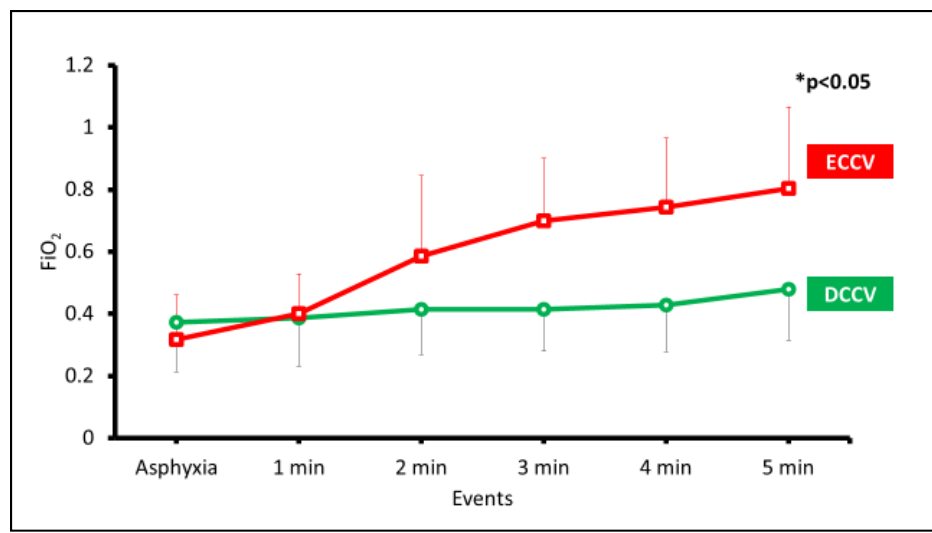
Figure 2. Fraction of inspired oxygen (FiO 2 ) is shown on the y-axis and the events or duration of PPV on the x-axis. The data are represented as average and standard deviation. The difference between ECCV and DCCV was significantly different (* p < 0.05 by ANOVA).